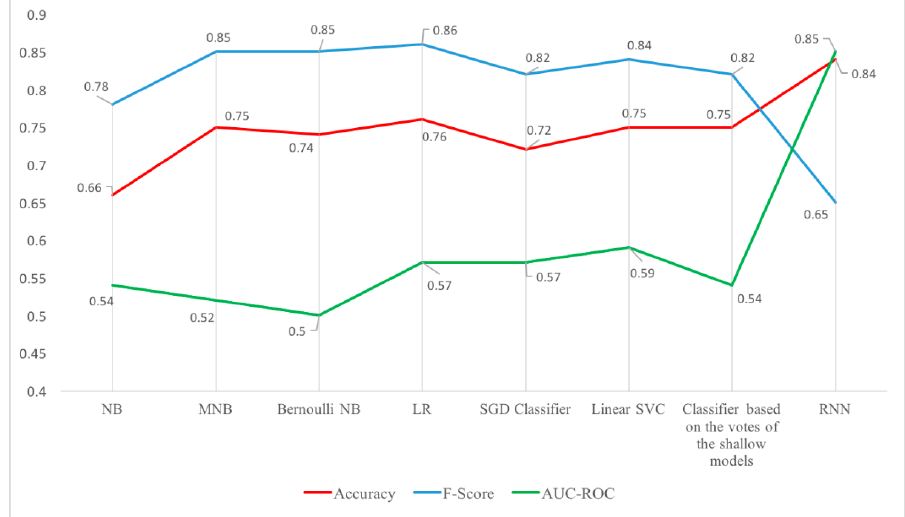
Figure 2. Evaluation metrics of the models generated with each of the algorithms.